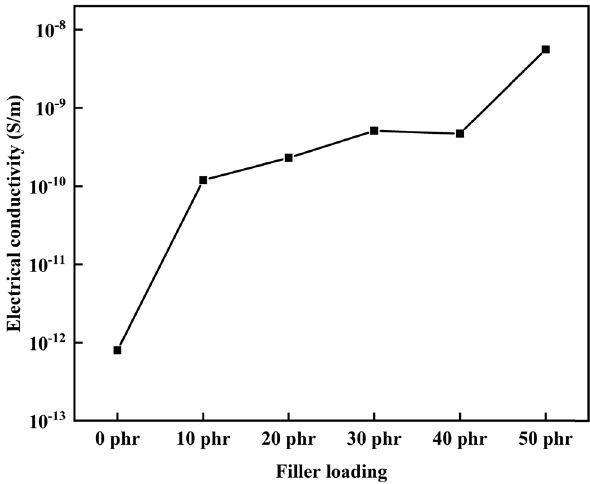
Figure 7: Electrical conductivity of NR composites with di ff erent CoFe 2 O 4 @BC loadings.